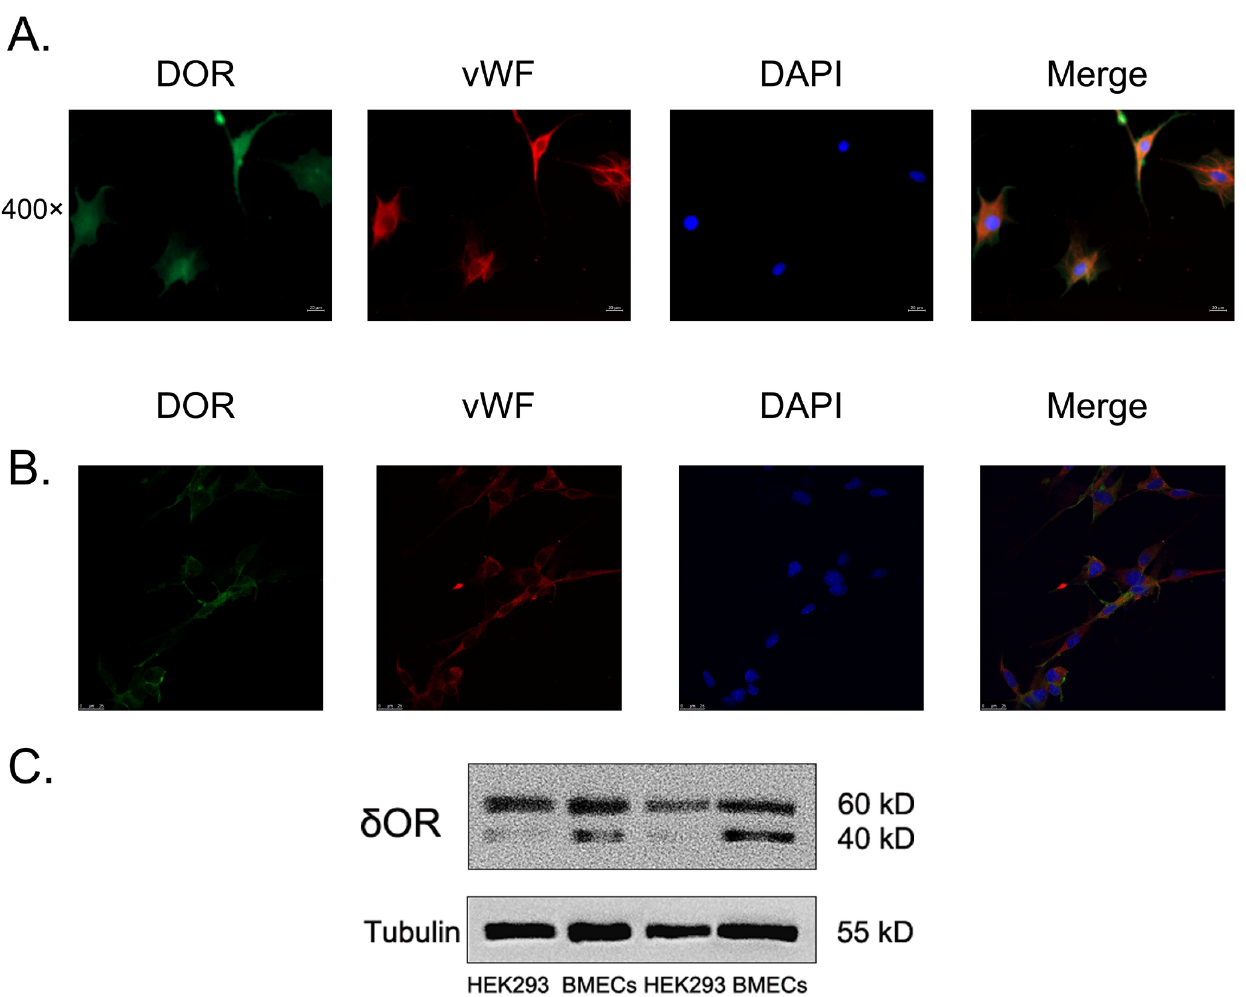
Figure 3. The primarily cultured BMECs express δ ORs. Typical immunofluorescence pictures ( A ) and confocal laser microscopy imaging ( B ) showed the expression of δ ORs (Green) and vWF (Red) on the BMECs. DAPI represented the nuclei and showed blue. ( C ) Western blotting detected the protein expression of δORs in the BMECs compared to that of HEK293 cells. Individual experiments were repeated three times.